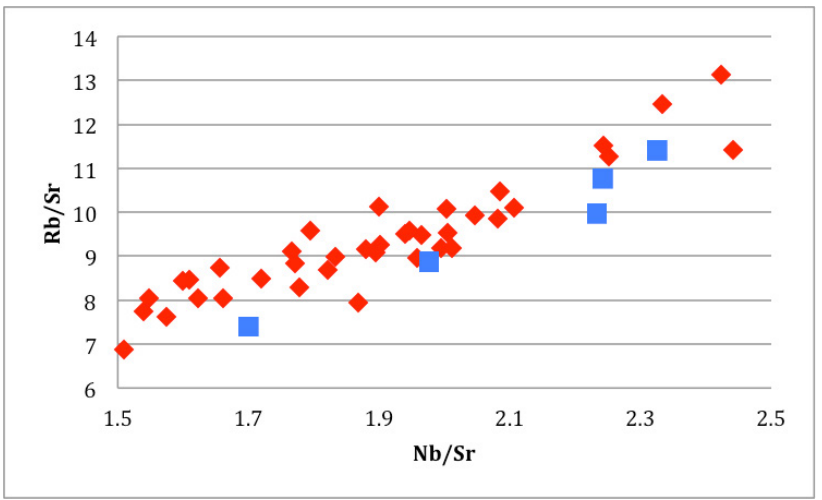
Figure 2b. Rb/Sr vs Nb/Sr. Stromboli: red diamonds; SdP, Lipari reference obsidian: blue squares. The latter fall within the Stromboli collection